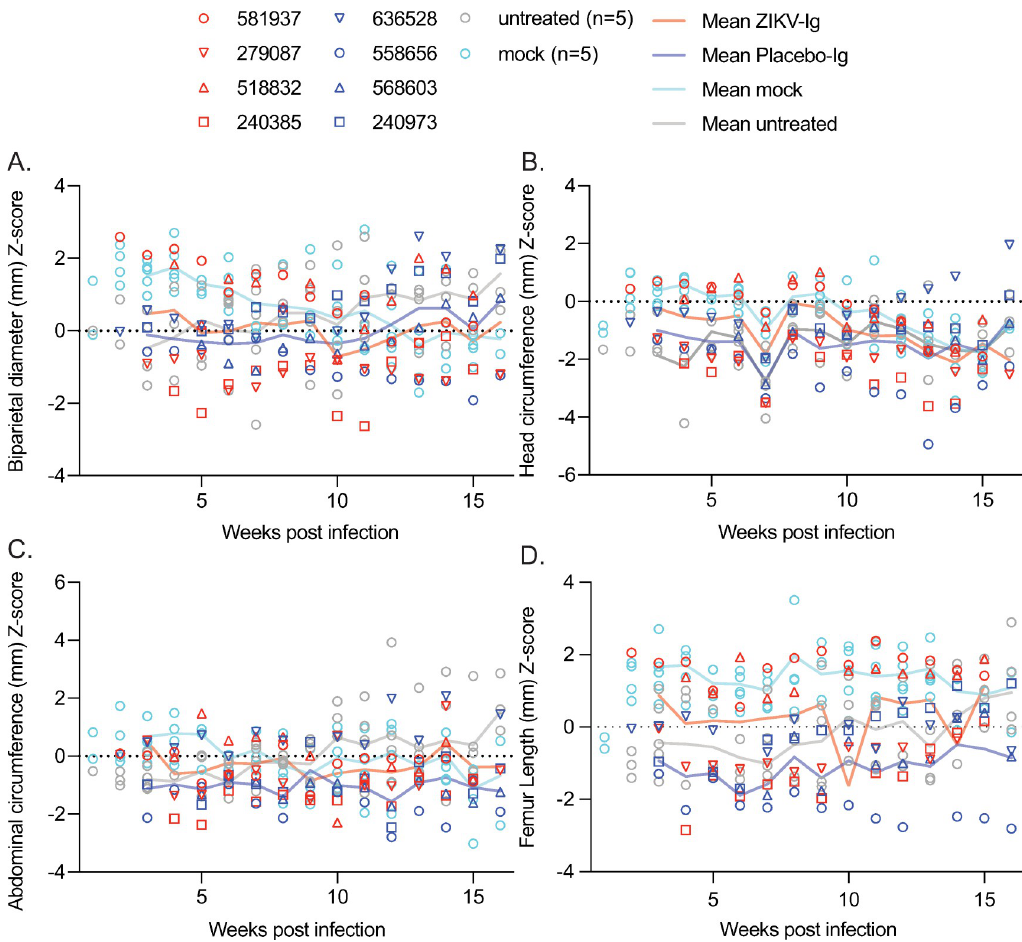
Fig 5. Ultrasound growth z-scores of ZIKV-IG, placebo-IG, untreated, and mock infected animals relative to normative data from CNPRC. The legend shows individual symbols for each ZIKV-IG and placebo-IG-treated animal while untreated and mock infected groups are represented by gray and turquoise open circles, respectively. Lines represent the mean z-score at each time point for each group starting at 3–4 weeks post-infection when data could be collected from all pregnancies. The dotted line represents no change from normative data set to 0. ( A ) Biparietal diameter z-scores. ( B ) Head circumference z-scores. ( C ) Abdominal circumference z-scores. ( D ) Femur length z-scores.